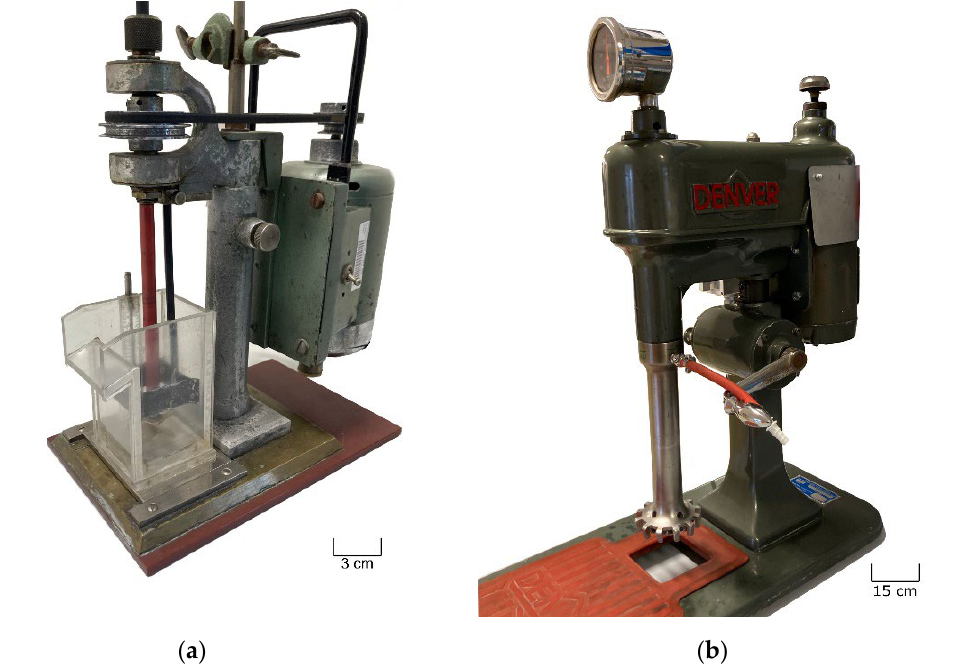
Figure 3. The flotation devices used for graphite removal from NCA samples: ( a ) the custom-made cell used for the preliminary flotation test; ( b ) Denver laboratory machine D-1 used for the actual NCA sample.